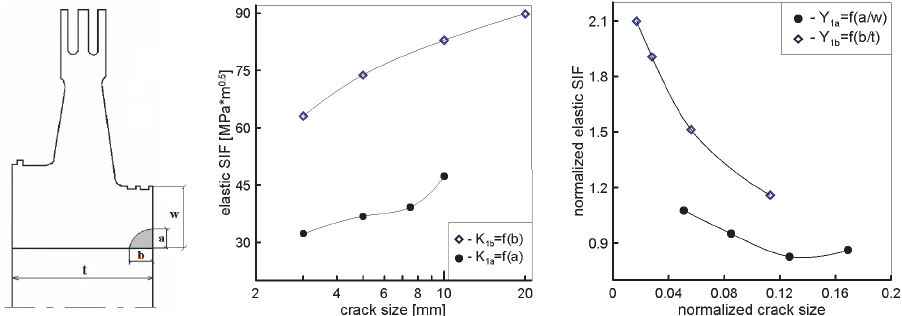
Figure 5: Elastic SIF versus crack size in depth and length direction.